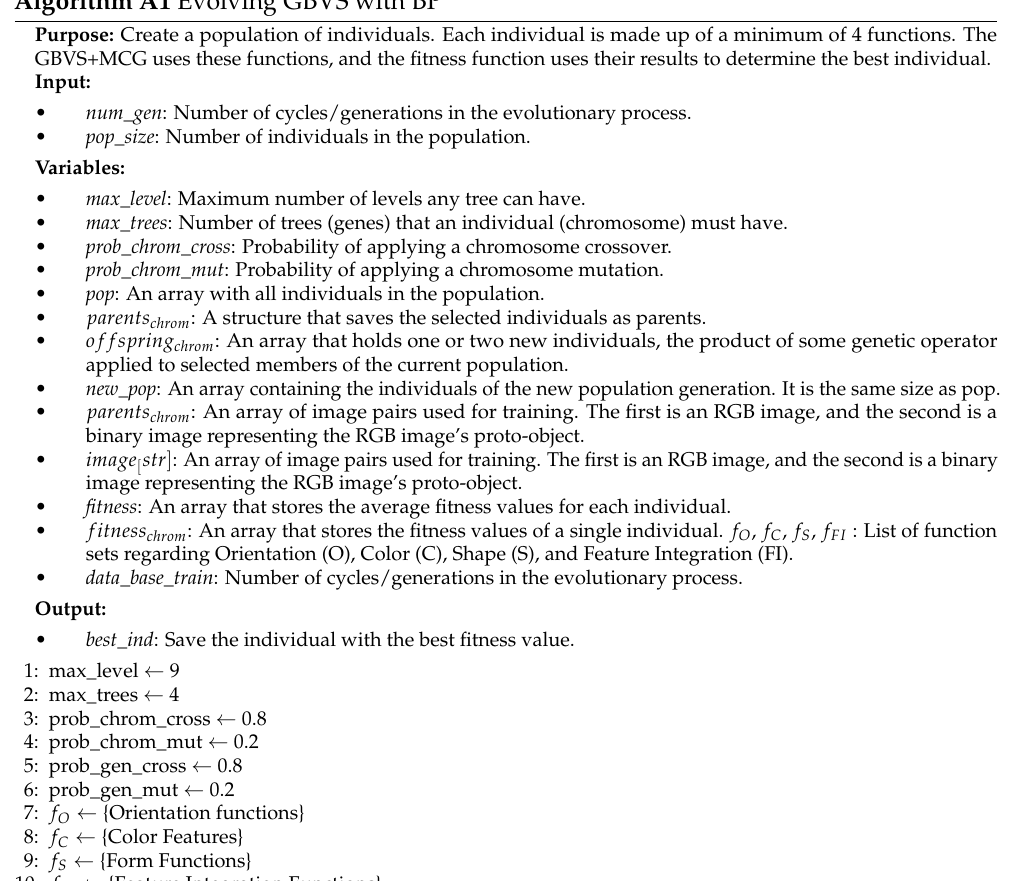
Algorithm A1 Evolving GBVS with